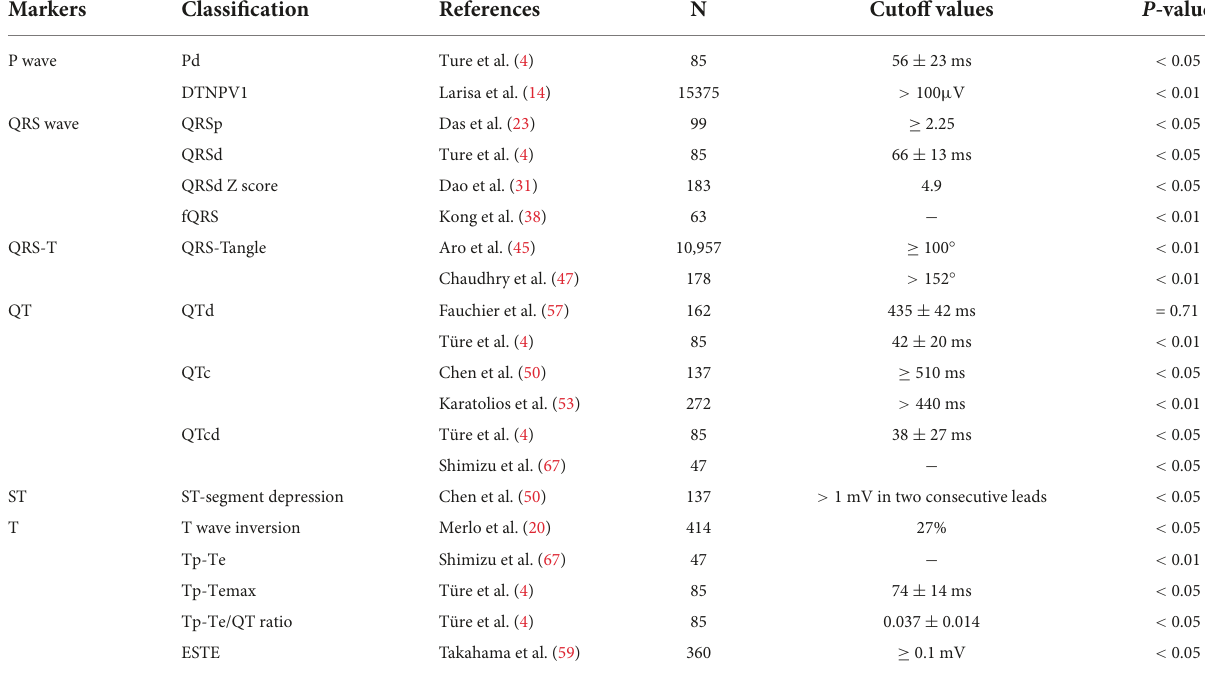
TABLE 1 Different electrocardiographic markers of adverse prognosis of children with DCM.